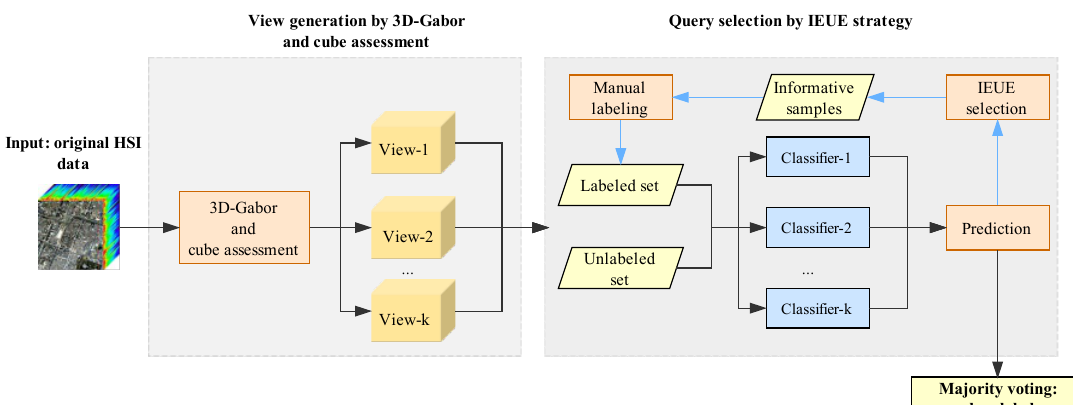
Figure 1. Flowchart of the proposed MVAL